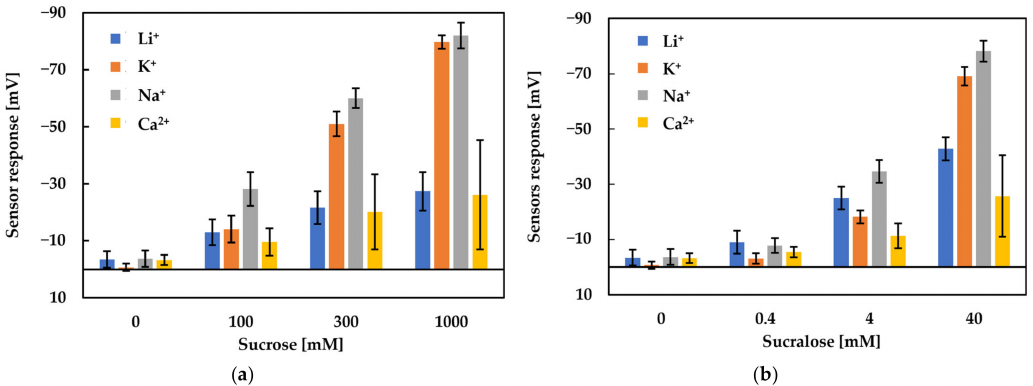
Figure 9. Sensor response to sweet substances: ( a ) sucrose; ( b ) sucralose.